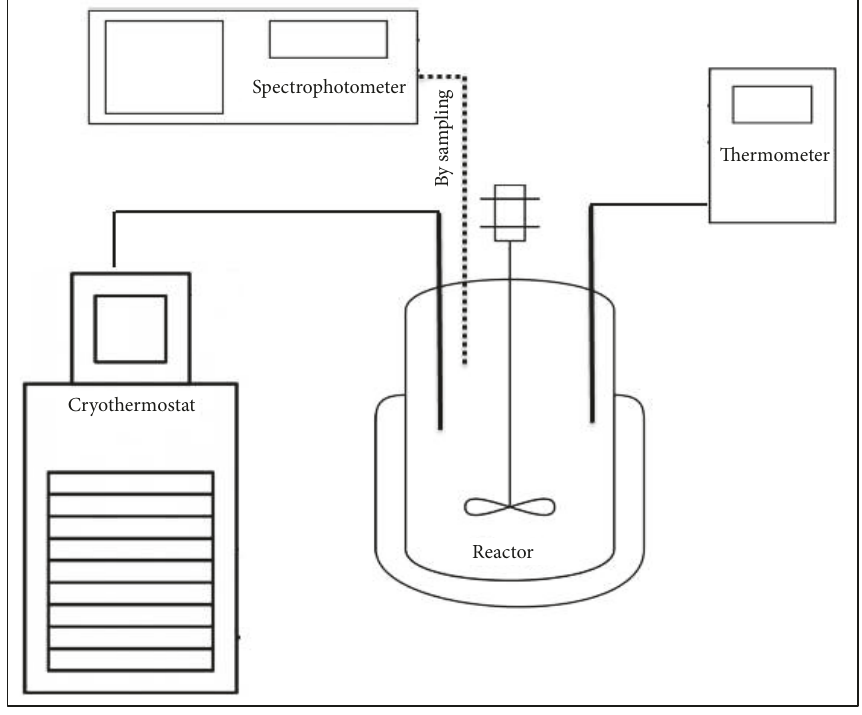
Figure 1: Experimental setup.